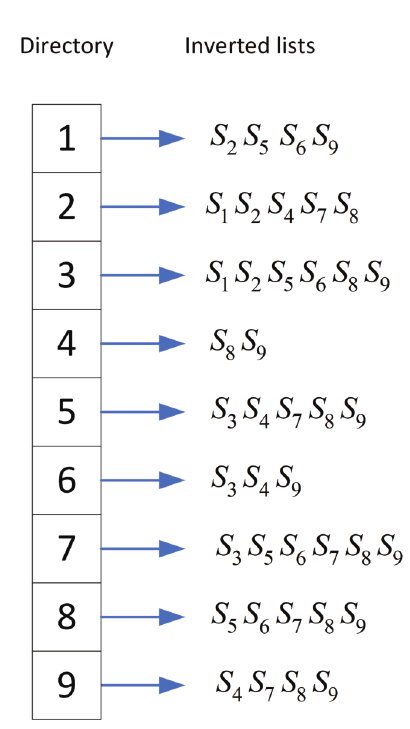
Figure 1. The inverted